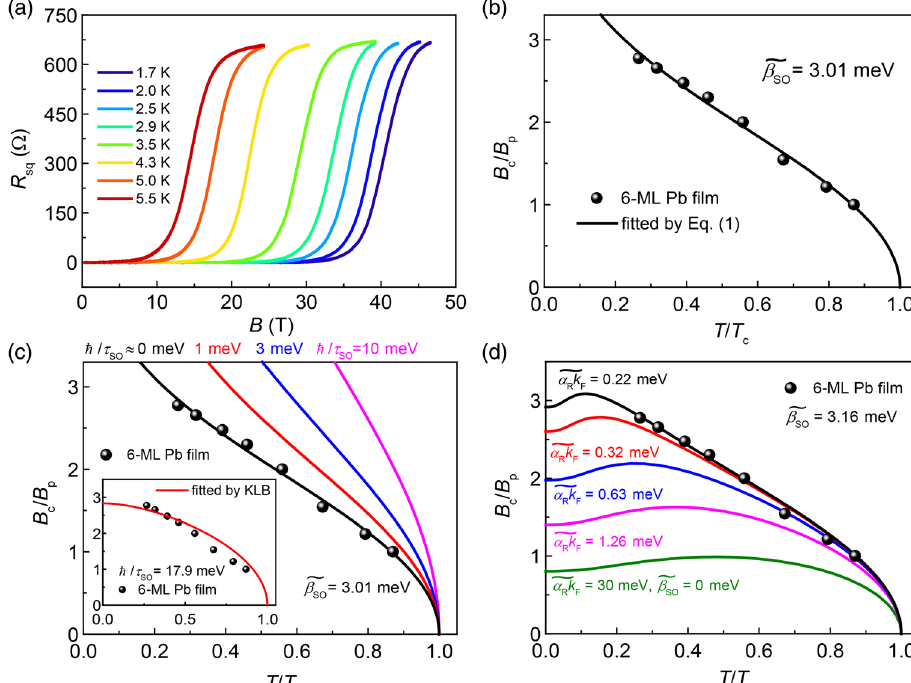
ð B Þ curves at various temperatures FIG. 4. Pulsed high magnetic field measurement for another 6-ML Pb film (sample 4). (a) R sq measured at parallel magnetic fields up to 47 T. The superconductivity survives under a high parallel magnetic field of 40 T at 1.7 K. (b) The in-plane critical field B c =B p as a function of normalized temperature T=T c for 6-ML Pb film, showing good agreement with the microscopic theory of Zeeman-protected superconductivity [black solid line, Eq. (1)] and yielding an effective Zeeman-type SOI g β SO ¼ 3 . 01 meV. (c) The B c =B p ( T=T c ) curve is fitted based on a microscopic theory considering both effective Zeeman-type SOI and ≈ 0 meV. The red, blue, and magenta lines indicate the theoretical spin-orbit scattering [black solid line, Eq. (2)], and it gives ℏ = τ SO ¼ 3 . 01 meV and increasing ℏ = τ curves with a fixed g β from 1 to 10 meV. Inset: The relationship between B c =B p and T=T c cannot SO SO be fitted by the KLB formula, which describes the in-plane critical field enhanced only by spin-orbit impurity scattering. (d) Theoretical fitting of B c =B p as a function of T=T c using a fixed effective Zeeman-type SOI and increasing effective Rashba-type SOI. The black ¼ 3 . 16 meV and effective Rashba-type SOI curve presents the best fit of the experimental data with effective Zeeman-type SOI g β SO g α R k F ¼ 0 . 22 meV. The olive line indicates a special case with only effective Rashba-type SOI ( g α R k F ¼ 30 meV, g β SO ¼ 0 ), which is far below the experimental